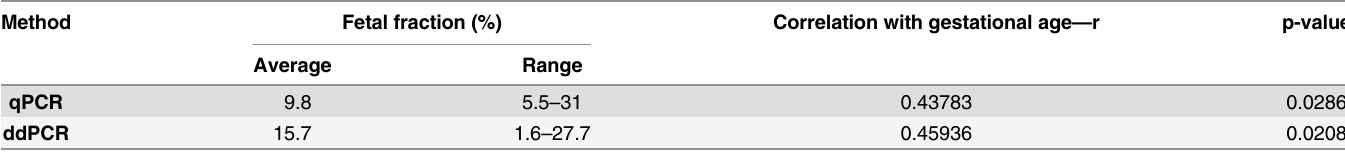
Table 3. Representation of fetal cfDNA fraction in maternal plasma as determined from RHD exon 10 /GAPDH concentration ratios measured by real-time PCR and ddPCR using 25 samples with RhD-positive